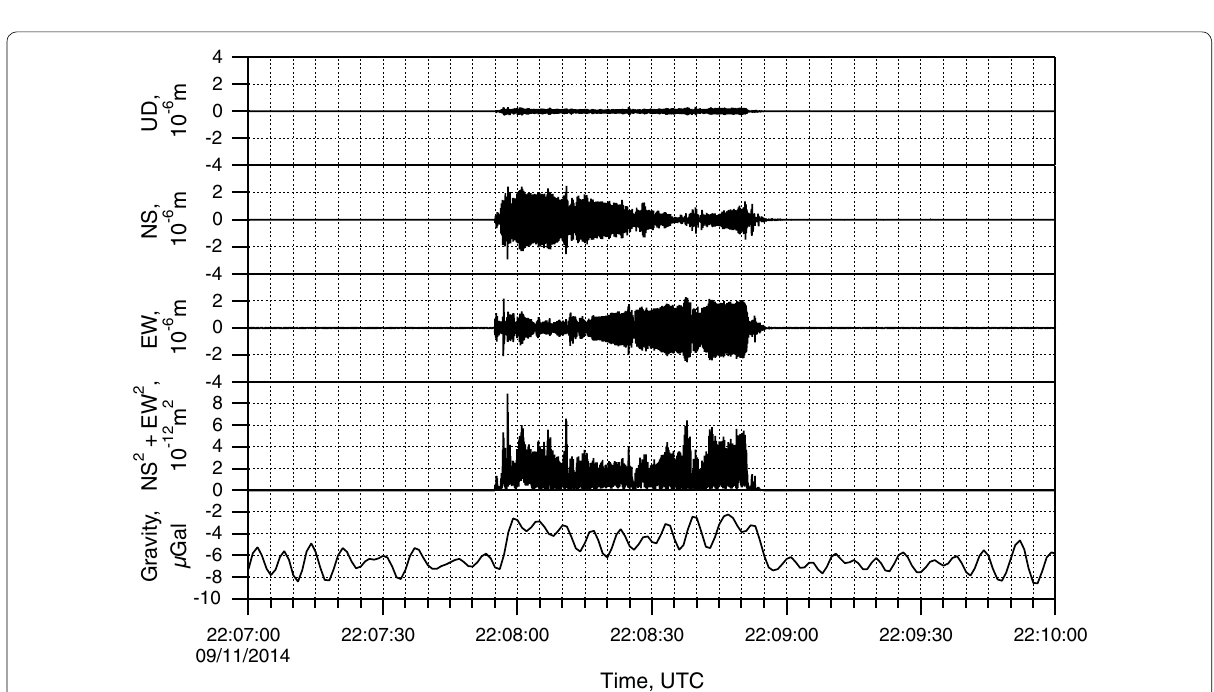
EW 2 ) is also shown for comparison with the +